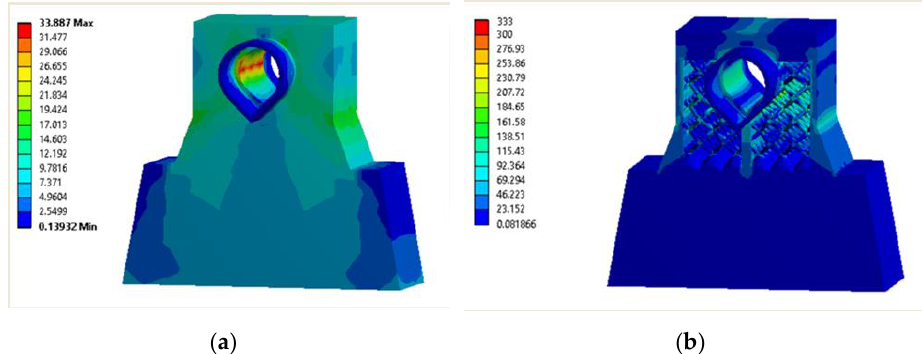
Figure 2. Stress analysis of demonstrators: ( a ) solid die; ( b ) lattice structured die .